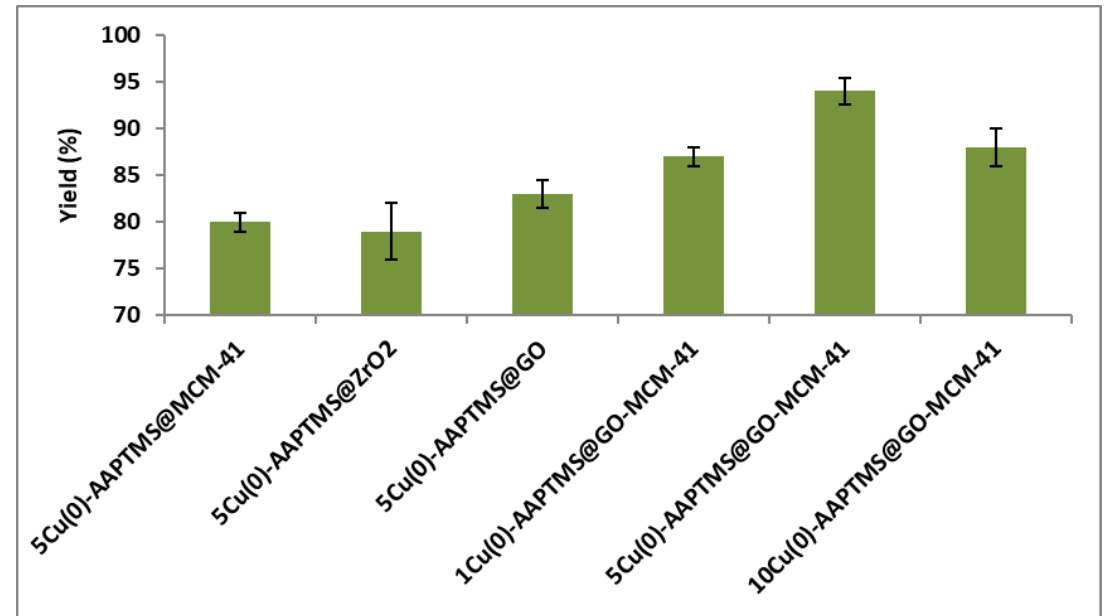
Figure 7. The activity of different catalysts towards the C-O Ullmann coupling reaction a . a Reaction conditions: Temperature, 100 °C; time, 7 h; catalyst, 0.03 g; solvent (DMF), 1 mL. Reactants: Aryl halides (1.5 mmol); Phenol (1.0 mmol); CsCO 3 (2 mmol).